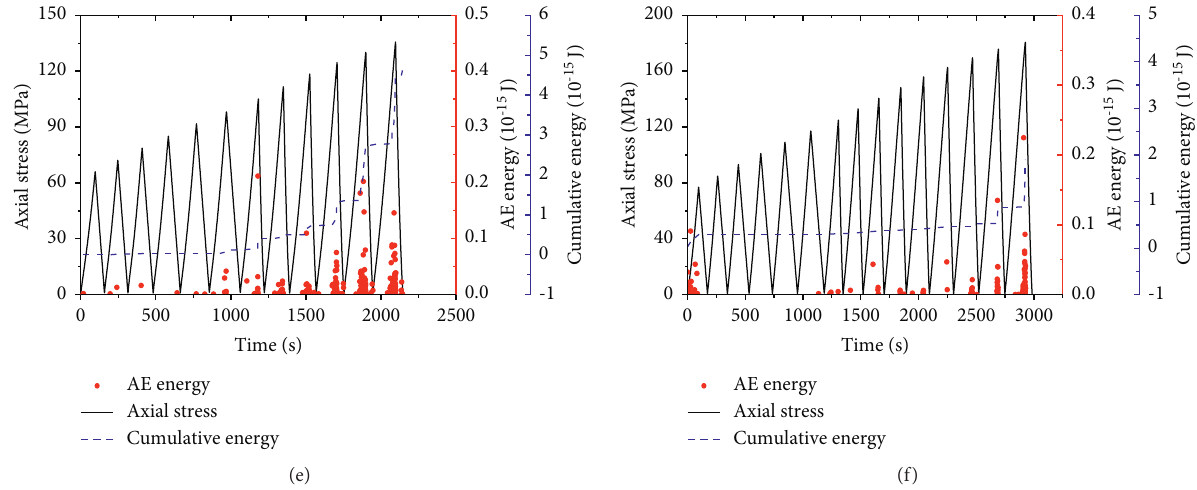
Figure 18: The axial stress-time-AE energy curves of phyllite ( σ sample, σ 3 � 5 MPa. (c) Saturated sample, σ 3 � 10MPa. (d) Dry sample, σ 3 � 10MPa. (e) Saturated sample, σ 3 � 20MPa. (f) Dry sample, σ 3 �